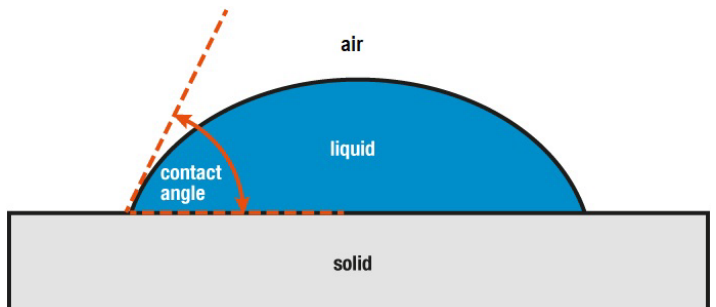
Figure 7. The water contact angle of a solid surface.